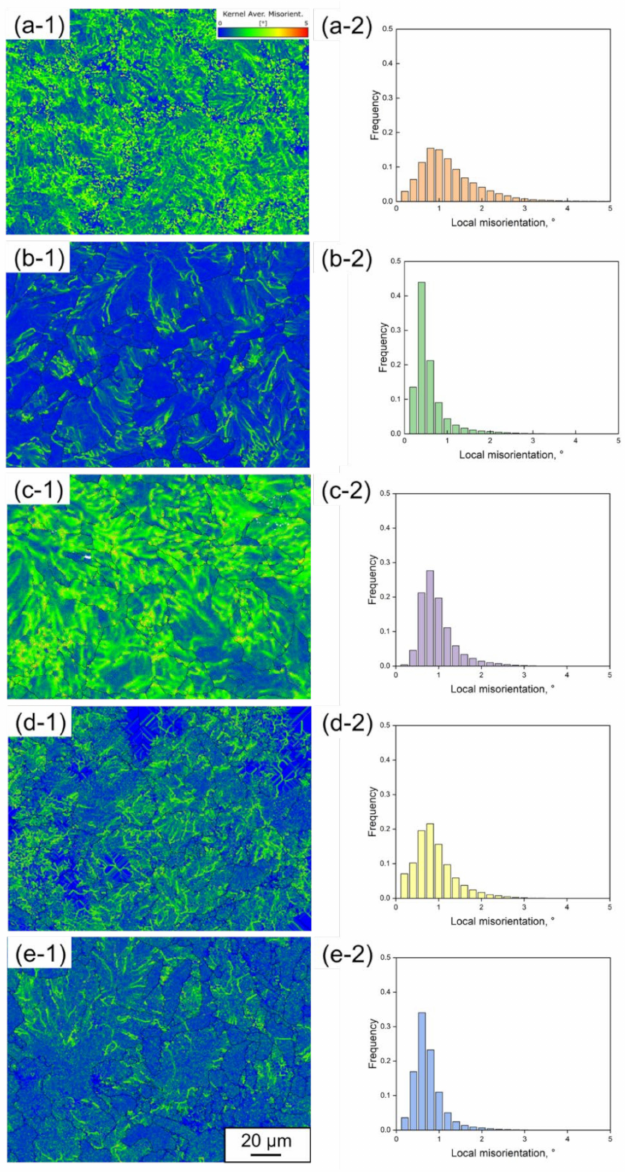
Figure 7. KAM + grain boundary maps and corresponding distribution diagrams of local misorienta- tion for the rail steels: ( a ) 1904, ( b ) 1911, ( c ) 1917, ( d ) 1919, ( e ) 1921, referred to as (-1) and